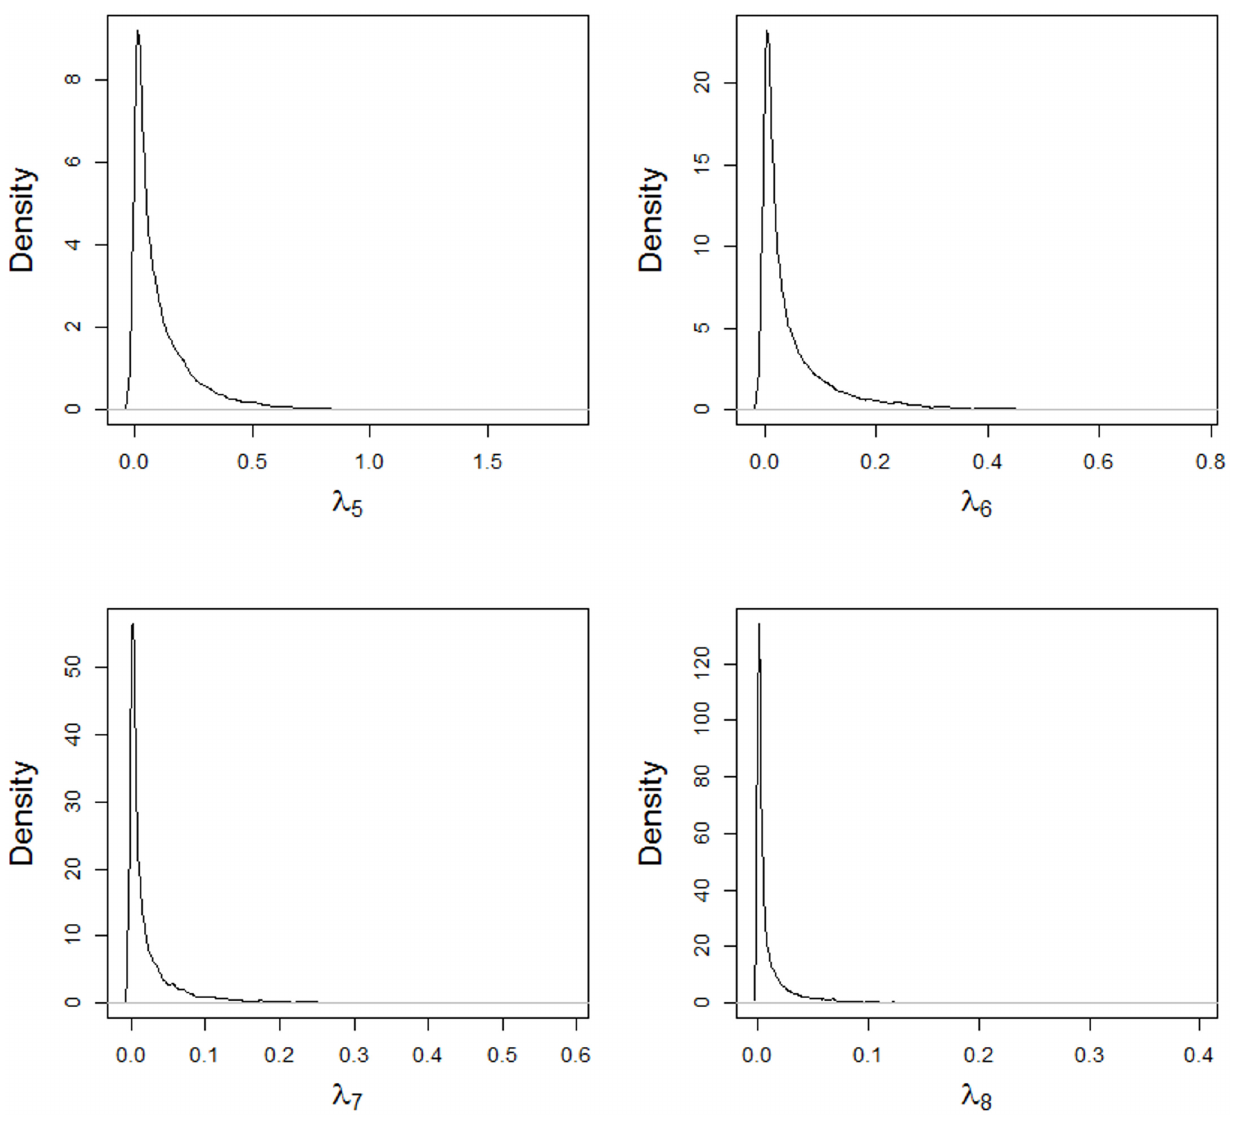
Fig 5. Posterior densities of the singular values λ 5 , λ 6 , λ 7 and λ 8 , obtained using the AMMIBS